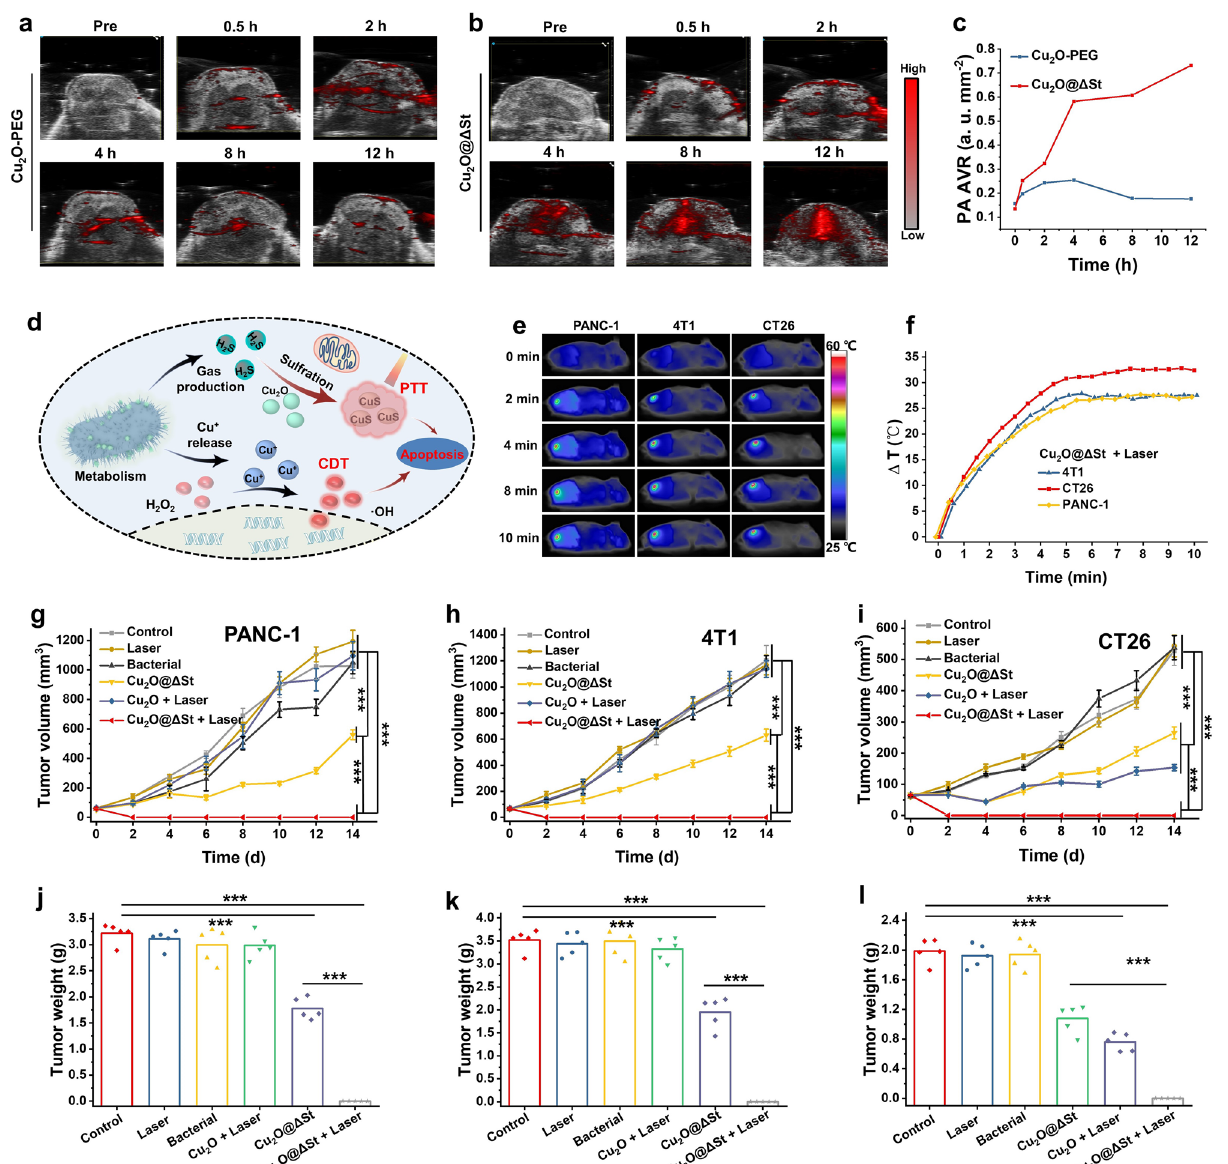
Fig. 4 In vivo tumor therapeutic effect of Cu 2 O@ΔSt on 4T1 on different tumor-bearing mice models. a, b PA images of CT26 tumor-bearing mice after intravenous injections of PEG-Cu 2 O NPs only and Cu 2 O@ΔSt, and c corresponding PA signal intensities at tumor sites. d Sche- matic illustration of the mechanism of Cu 2 O@ΔSt-triggered therapeutic effect. e IR images at different time intervals of mice after injections of Cu 2 O@ΔSt. f The corresponding temperature elevations over time of mice after different treatments. The tumor volumes and weights of differ- ent types of tumor-bearing mice at the ends of various treatments, including g, j PANC-1 tumor-bearing mice model, h, k 4T1 tumor-bearing mice model, and i, l CT26 tumor-bearing mice model ( n = 5, mean ± standard